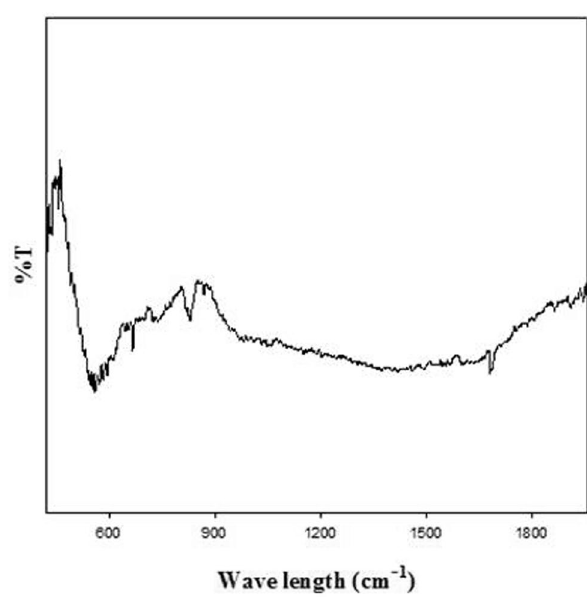
Fig. 3 FT-IR spectrum of TiO